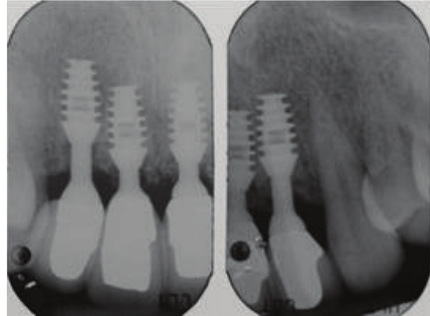
Figure 21: Radiographs at five-year follow-up showing interproxi- mal bone and bone at implant shoulder.